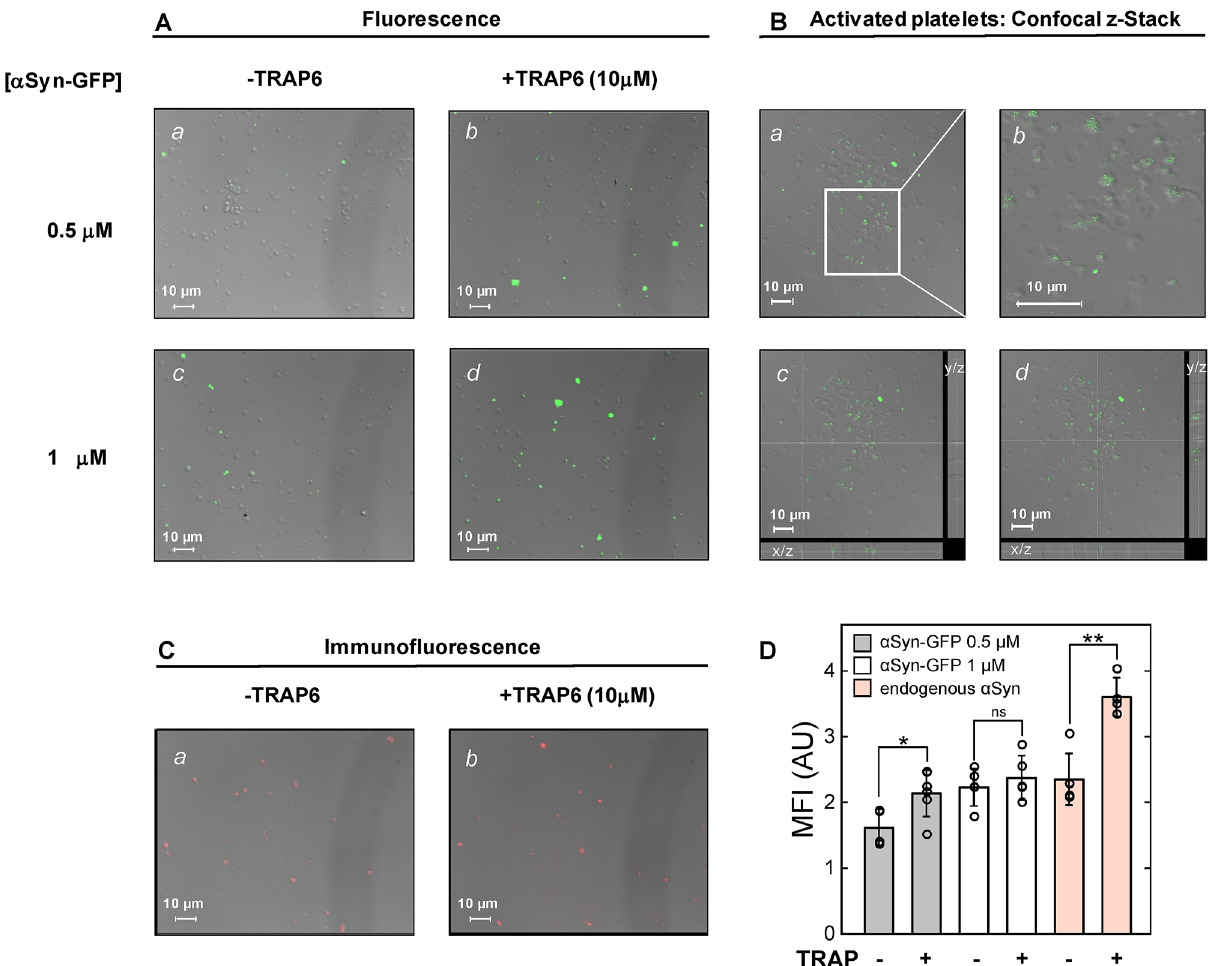
Figure 4. Fluorescence microscopy analysis of αSyn membrane localization in resting and activated platelets. Pictures result from merging fluorescence and differential interference contrast images (grey images) while platelet count was at 2 × 10 6 platelets/well in all experiments. ( A ) Representative fluorescence microscopy images of exogenous αSyn binding to platelets. Isolated platelets were seeded, while increasing concentrations of αSyn-GFP (0, 0.5, and 1.0 μM) in HBS were added (1 h, 37 °C) to resting (− TRAP6) and activated (+ TRAP6) platelets, as indicated in panels a – d . After washing and paraformaldehyde fixation, seeded platelets were analysed by fluorescence microscopy. ( B ) panel a , Representative fluorescence confocal microscopy image of platelets activated with TRAP6 (10 μM) and then incubated (1 h, 37 °C) with exogenous αSyn-GFP (1 μM); panel b , Magnification of the rectangular area shown in panel a ; panels c and d , Z-stack analysis of the fluorescence confocal image shown in panel a . Projections onto x/z and y/z planes are side views of serial confocal sections of the same area. ( C ) Representative immunofluorescence microscopy images of endogenous (i.e. cytoplasmic) platelet αSyn in resting and activated platelets. Resting (panel a ) (− TRAP6) and activated (panel b ) (+ TRAP6) platelets were seeded, fixed with paraformaldehyde and incubated (1 h, 37 °C) with mouse anti-human αSyn monoclonal antibody, followed by addition of a diluted Alexa Fluor 594-conjugated goat anti-mouse IgG (red fluorescence). Unspecific binding was assessed by incubating platelets with the secondary antibody alone. ( D ) Mean fluorescence intensity (MFI) values of exogenous αSyn-GFP and endogenous (i.e. cytoplasmic) αSyn bound to resting (− TRAP6) and activated (+ TRAP6) platelets. Data points are shown as empty circles ( ○ ), while the height of the histograms is the mean value ± SD (n = 4–6). Significant differences were obtained from Student’s t-test and are indicated by lines joining the data being compared (* p value < 0.05; ** p value < 0.01; ns: not could also detect some basal exposure of endogenous αSyn even in resting platelets (Fig. 4C-a). Noteworthy, this exposure is significantly increased in TRAP6-activated platelets, compared to resting platelets (Fig. 4C-b and D). Effect of αSyn on fibrin generation. The effect of αSyn on fibrin generation, from αT with purified fibrinogen, was monitored by turbidimetric analysis. The data shown in Fig. 5 indicate that, in the presence of αSyn, the clotting time (t c ) remains essentially constant (109 ± 5 s), while the maximal change in turbidity (ΔA max ) progressively increases up to 17 ± 2% at 10 μM αSyn (Fig. 5, Inset). These results suggest that αSyn does